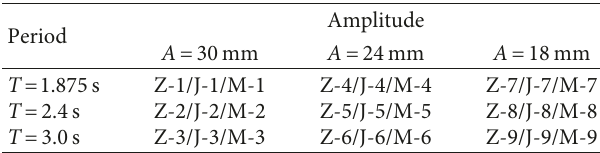
Table 3: Harmonic vibration loading